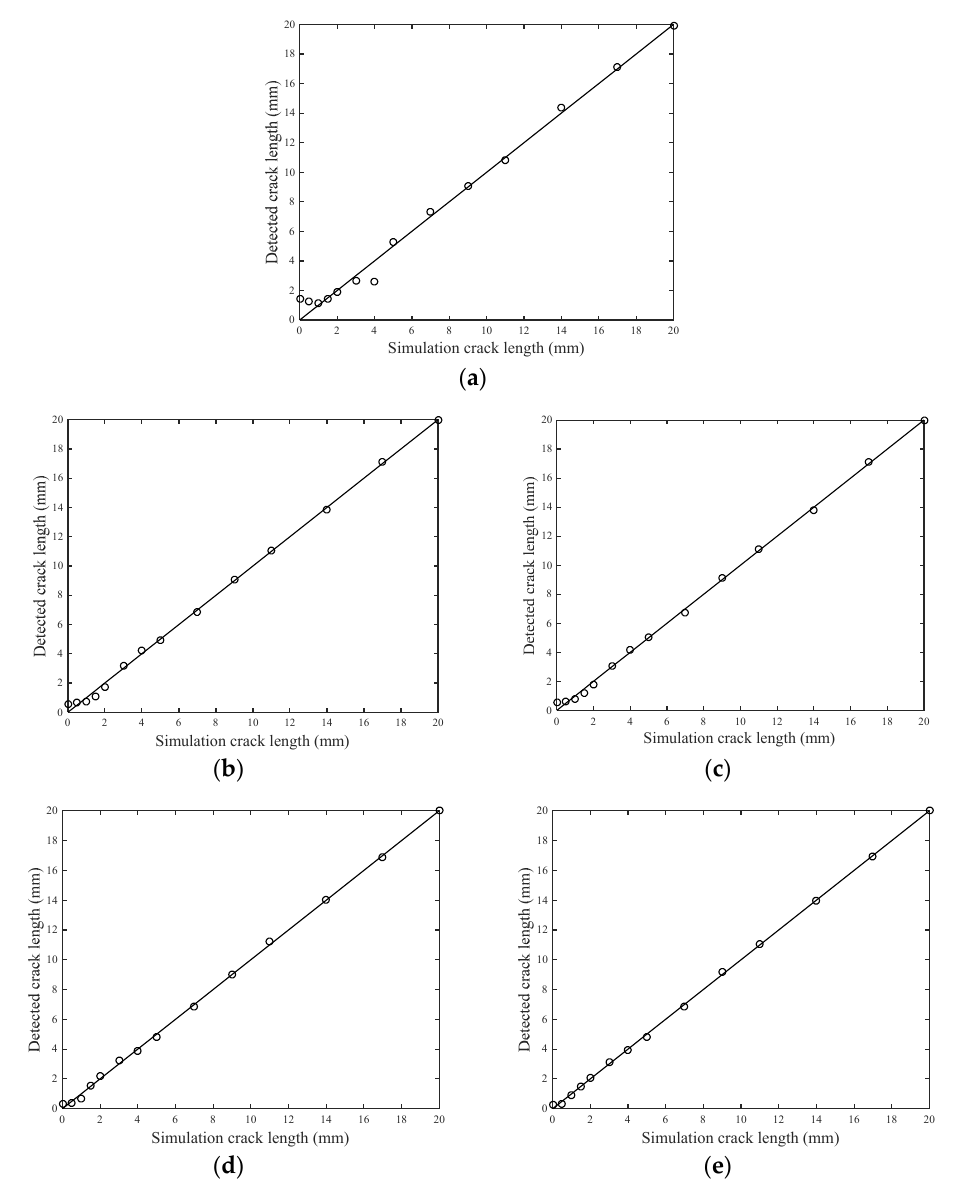
Figure 13. Fitting curves: ( a ) 3.5 cycle Hanning-windowed tone burst signal; ( b ) 0~300 kHz L-Chirp signal; ( c ) 150 kHz GCC signal; ( d ) 300~700 kHz L-Chirp signal; and ( e ) 500 kHz GCC signal.